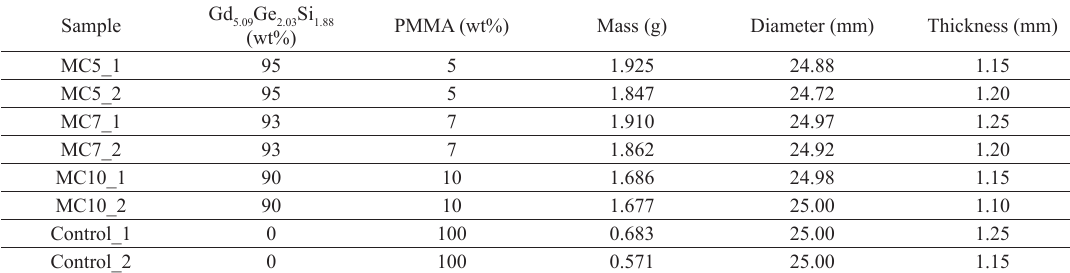
Table 1. Composition, mass and dimension of composite samples.